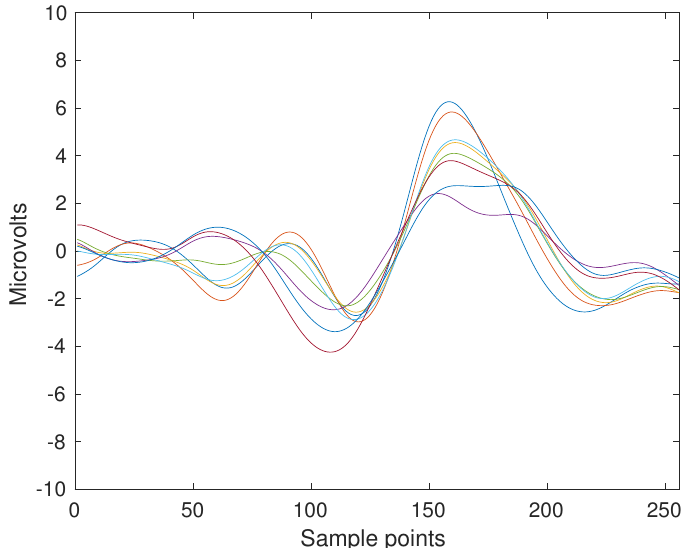
Figure 2. ERP Template obtained from the coherent point-to-point ensemble average from the signals of Subject Number Eight of the BNCI Horizon public dataset 008-2014. The template is 1 s long which is 256 sample points, and the eight channels are superimposed with different colors. The P3b component can be seen around the sample index 150 and